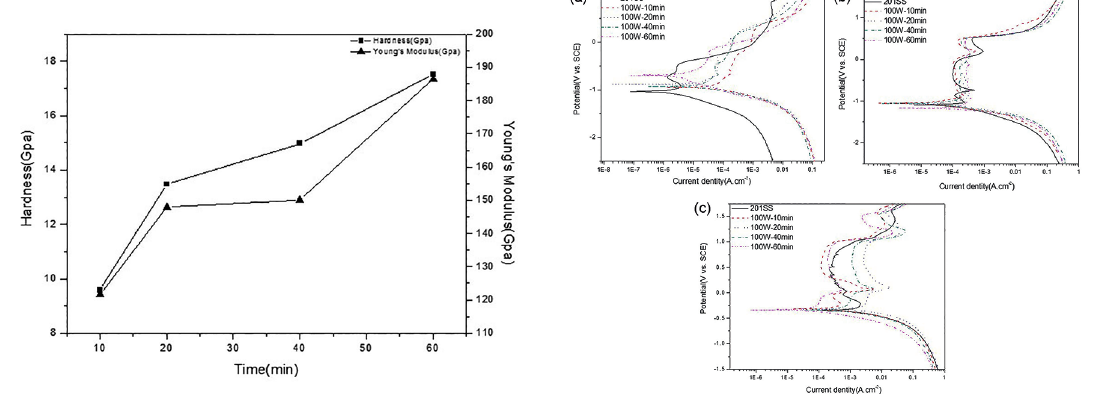
in different corrosion mediums. (a) 3.5 NaCl, (b) 5% NaOH, (c) 10% H SO . 2 4